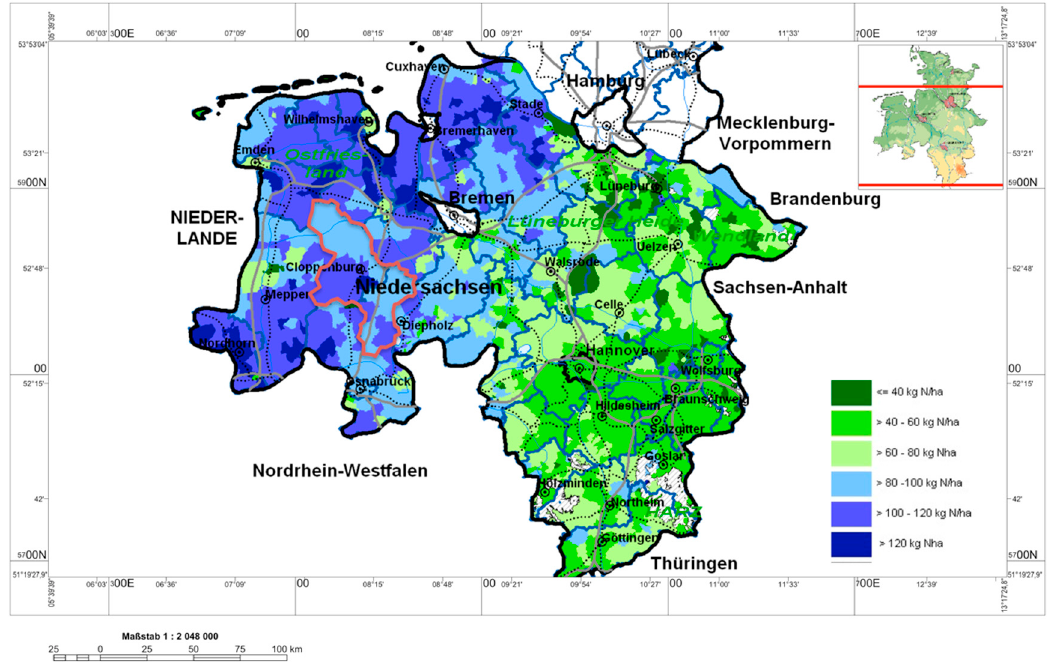
Figure 1. Case study regions Cloppenburg and Vechta and nitrogen levels. Nitrogen levels in Lower Saxony, marked in red are the case study regions Cloppenburg and Vechta (source: NIBIS® Kartenserver (2014): Stickstoff-Flächenbilanzsaldo auf Gemeindeebene, Landesamt für Bergbau, Energie und Geologie (LBEG), Hannover; study region marked by the authors).